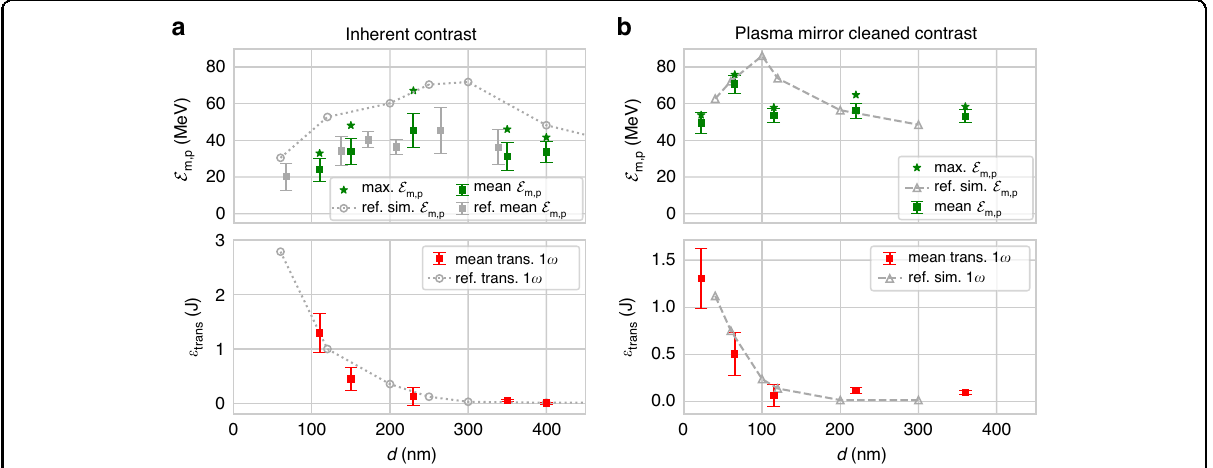
Fig. 6 DRACO-PW experiments studying pre-expansion in fl uence. Measurements of maximum proton energy E m,p (green squares) and transmitted 1 ω light Ɛ trans ( red squares) for different target thicknesses d from experiments at DRACO-PW for a inherent and b plasma mirror cleaned temporal contrast. Reference J-KAREN-P proton energy data (grey squares) is included for comparison. The error bars represent the standard deviation of mean values (squares), stars show maximum values of E m,p . Grey circles and triangles show reference E m,p and Ɛ trans from the 3D PIC simulations presented in Fig.